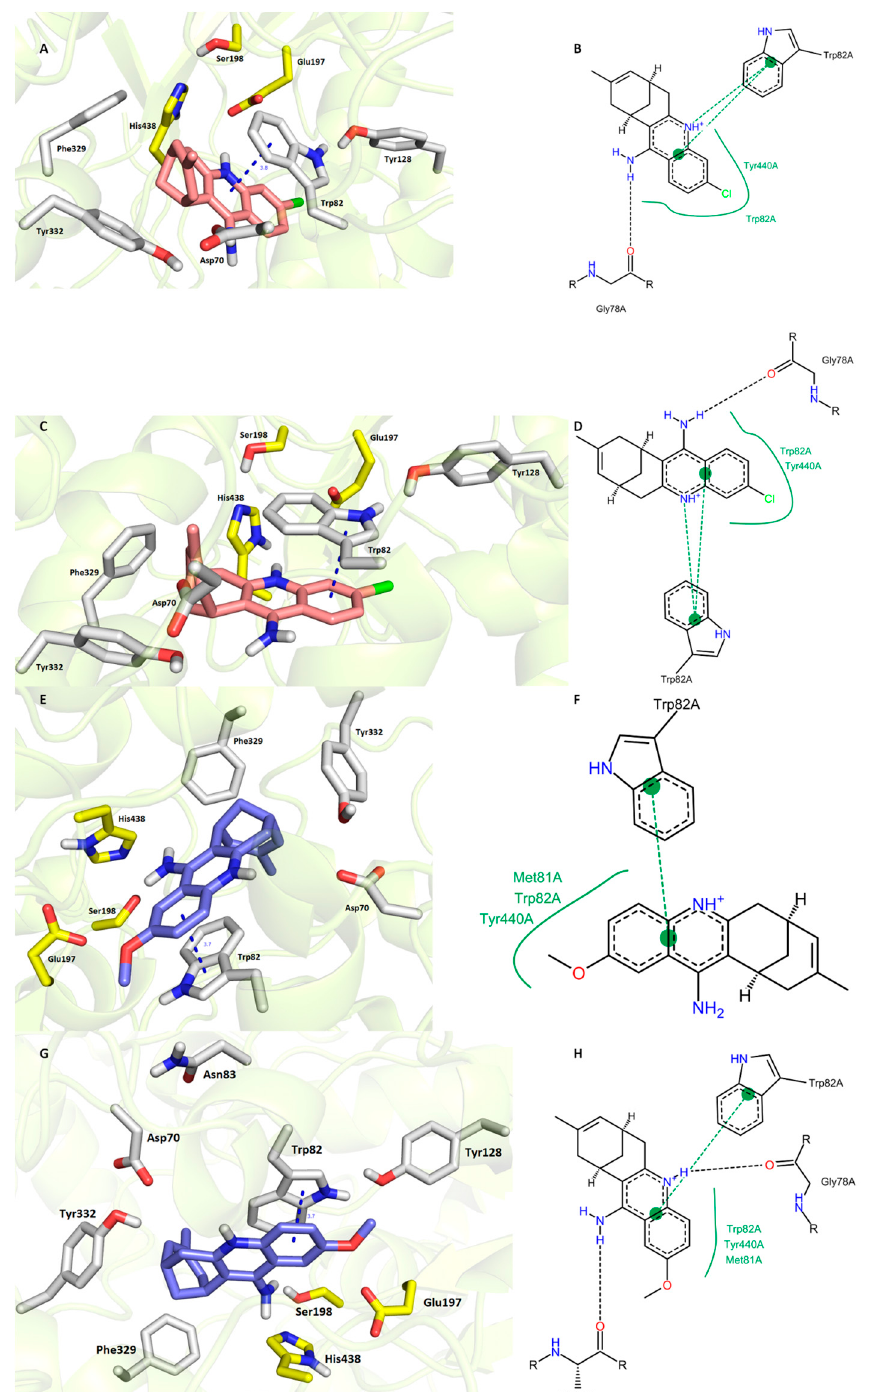
Figure 5. Docking results for HupY (( A , B )—7 R ,11 R -HupY; ( C , D )—7 S ,11 S -HupY) and 1 (( E , F )-7 S ,11 S - 1 ; ( G , H )—7 R ,11 R - 1 ) within h BChE active site (PDB ID: 4BDS). Generally to A, C, E, G—HupY is rendered in salmon carbon atoms; 1 is depicted in dark blue carbon atoms; important amino acid residues involved in the ligand-enzyme interactions are displayed in grey carbon atoms; catalytic triad residues (Glu198, Ser197, His438) are shown in yellow; rest of the enzyme is represented in grey cartoon; ( B , D , F, and H )—2D representation of binding modes of HupY and 1 . Figure ( B , D , F, and H ) were created with PoseView software (PoseView, http://poseview.zbh.uni-hamburg.de/poseview/wizard, 2012); Figure ( A , C , E and G ) were generated with PyMol 1.30 (The PyMOL Molecular Graphics System, Version 1.5.0.4 Schrödinger, LLC.).